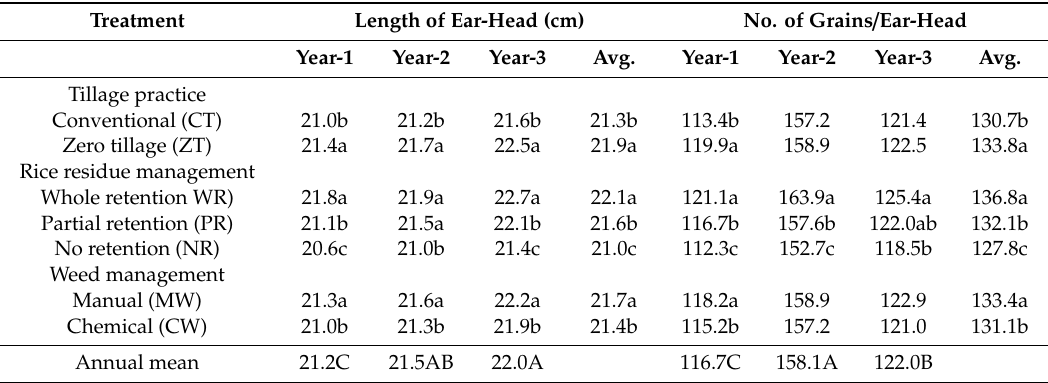
Table 4. Length of ear-head and number of grains / ear-head of rice under di ff erent tillage, crop residue and weeding managements. Di ff erent lowercase letters within a column indicate significant di ff erence with a treatment. Di ff erent uppercase letter within a row for annual mean values (last row) indicate significant di ff erence among the study years.